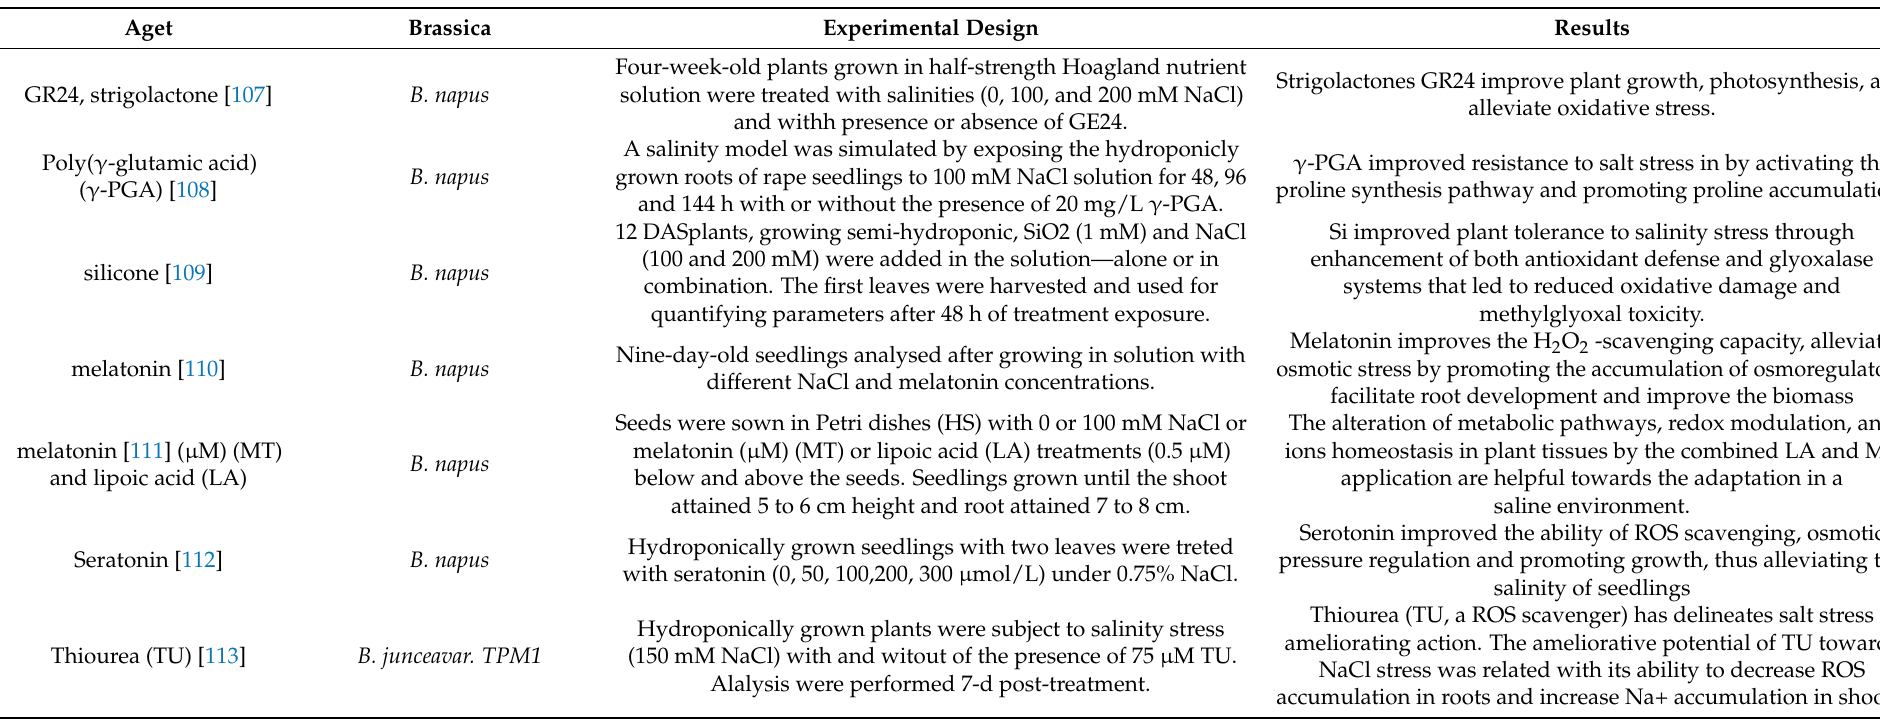
Table 4. List of root treatments by beneficial molecules and their ameliorative effects on Brassica species under salinity